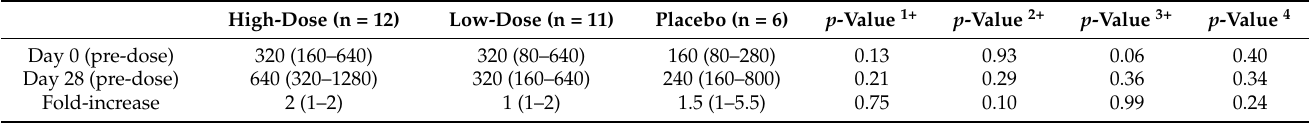
Table 7. Summary of influenza A H1N1 haemagglutination inhibition